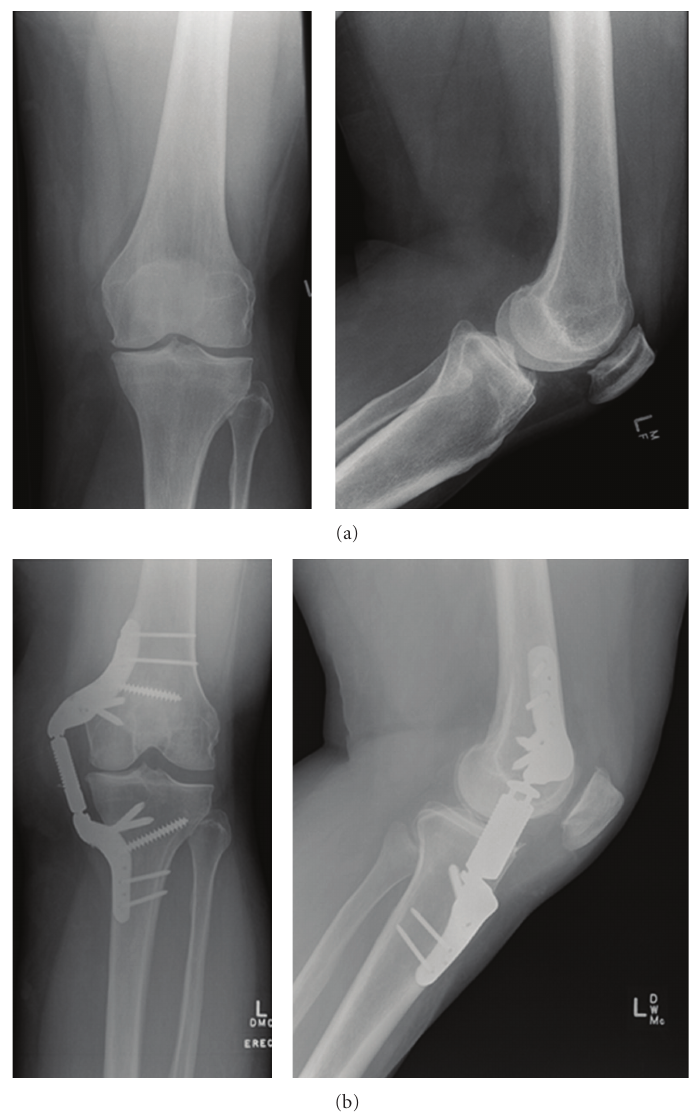
Figure 3: Anterior (left) and medial (right) radiographic view of the left knee at pretreatment (a) and at 3 years demonstrating the KineSpring System in situ